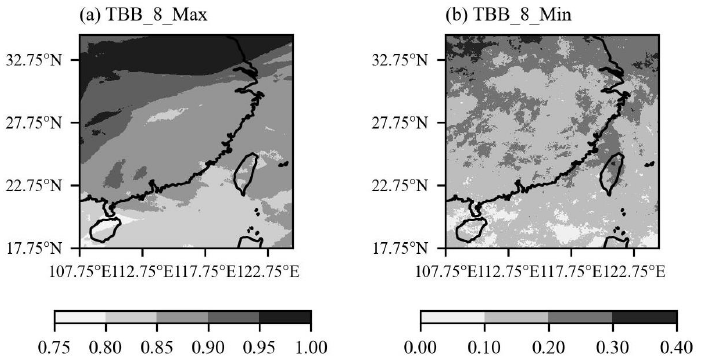
Figure 8. The maximum ( a ) and minimum ( b ) value distributions of TBB from band 8 after Area- based normalization.